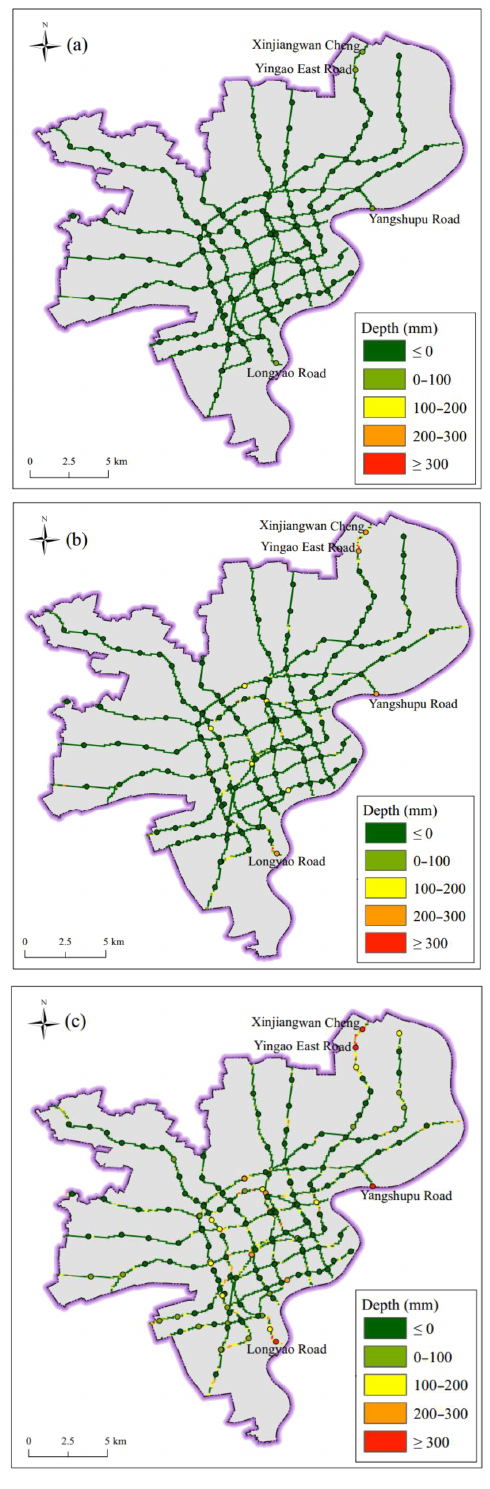
Figure 7. Potential inundation depth around the metro stations un- der different scenarios: (a) 50-year, (b) 100-year, and (c) 500-year rainfall